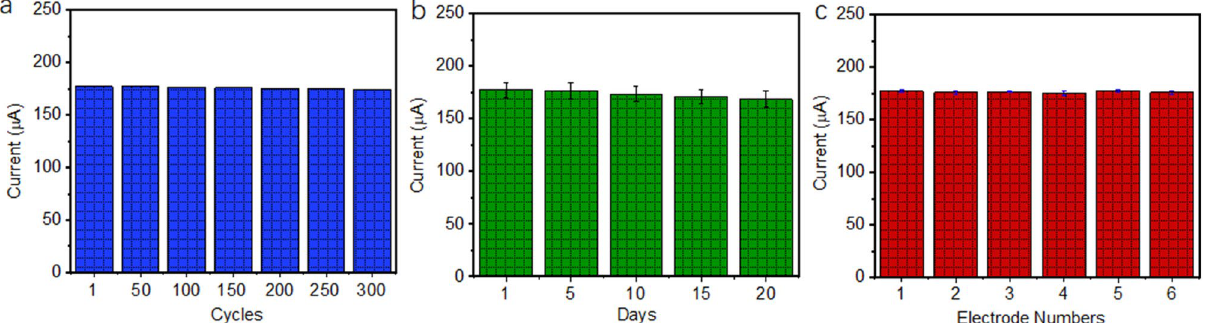
Figure 7. The stability of the PtNi alloy-graphene/GC electrode for glucose detection ( a ) at different cycles and ( b ) for days. ( c ) The current responses of six PtNi alloy-graphene/GC electrodes with 10 mM glucose.